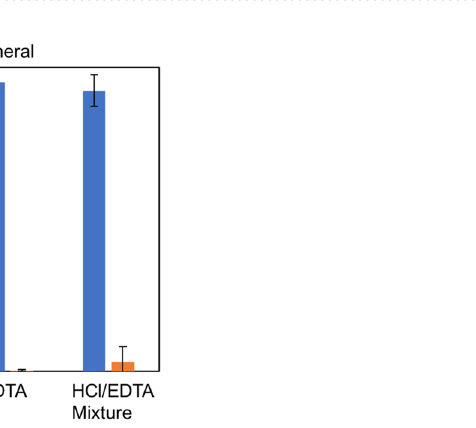
Figure 4. Thermogravimetric analysis results after heating to 800 ˚C: weight percentage of mineral and protein once water is removed after each demineralization